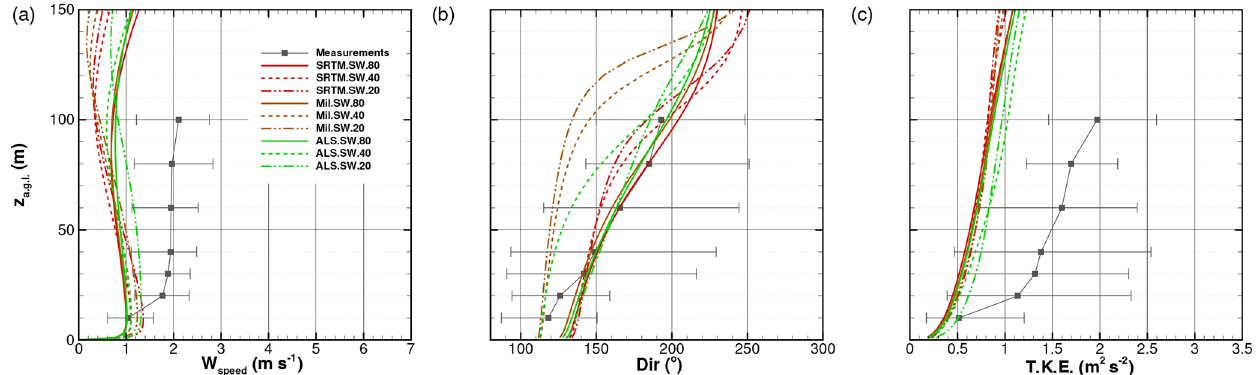
Figure 15. Simulation results and experimental data in tower 25/tse09 for SW winds: (a) wind speed, (b) wind direction, (c) turbulent kinetic energy.